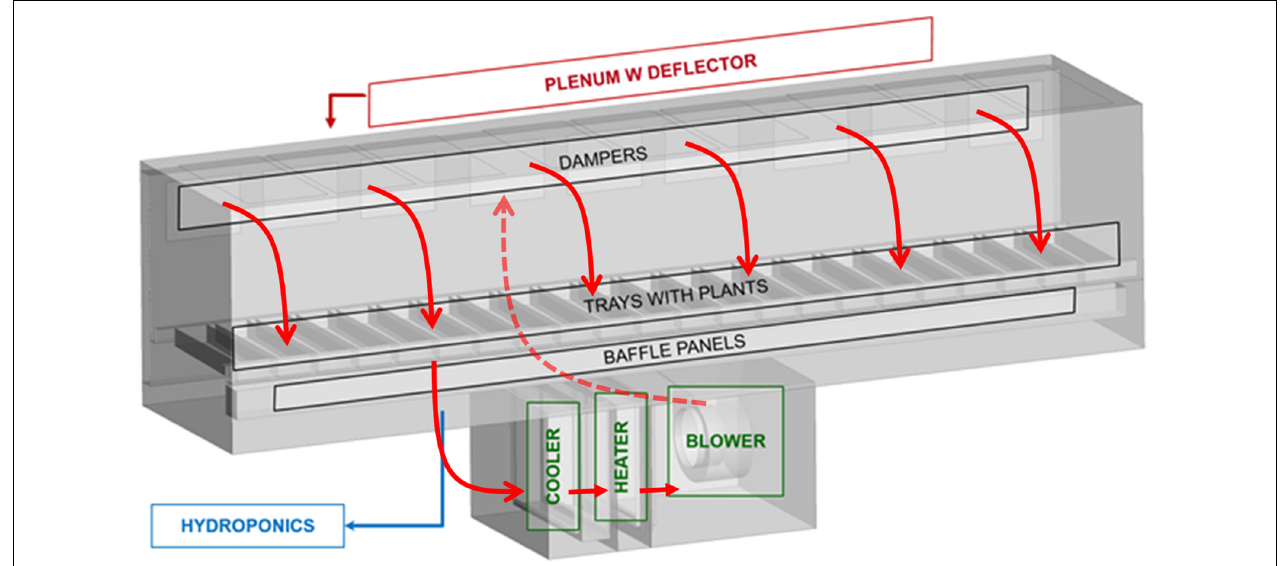
FIGURE 2 | Perspective view of the Higher Plant Compartment, highlighting the air circulation system and components and showing the airflow fluxes (red arrows).